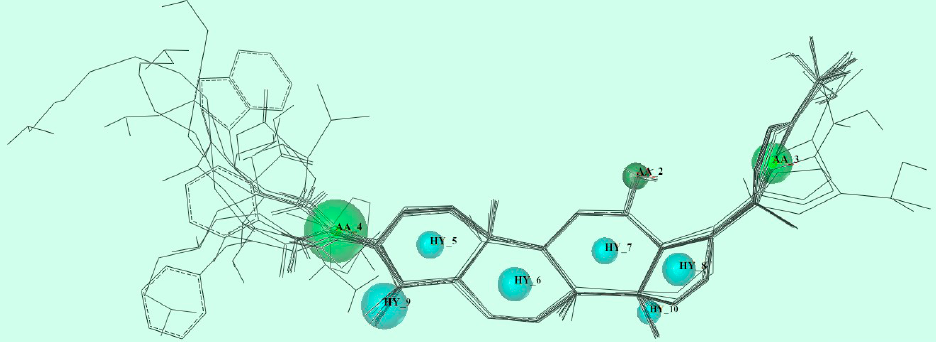
Figure 3. Pharmacophore requirements.